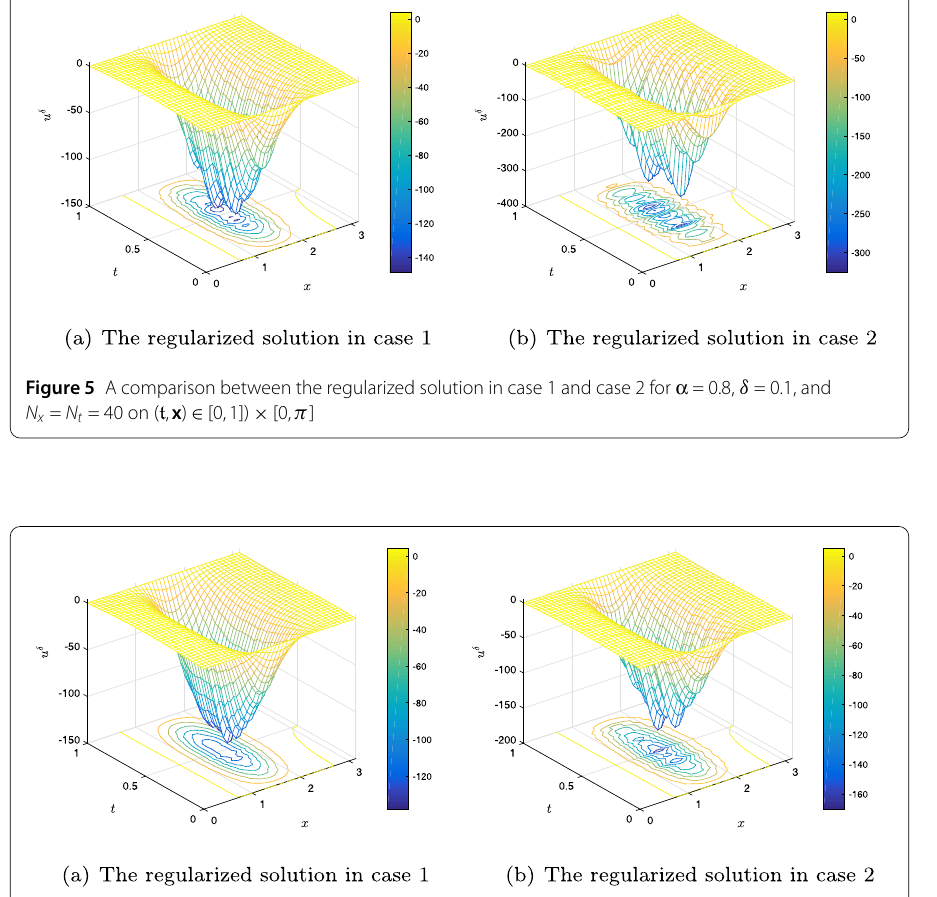
Figure 6 A comparison between the regularized solution in case 1 and case 2 for α = 0.8, δ = 0.01,